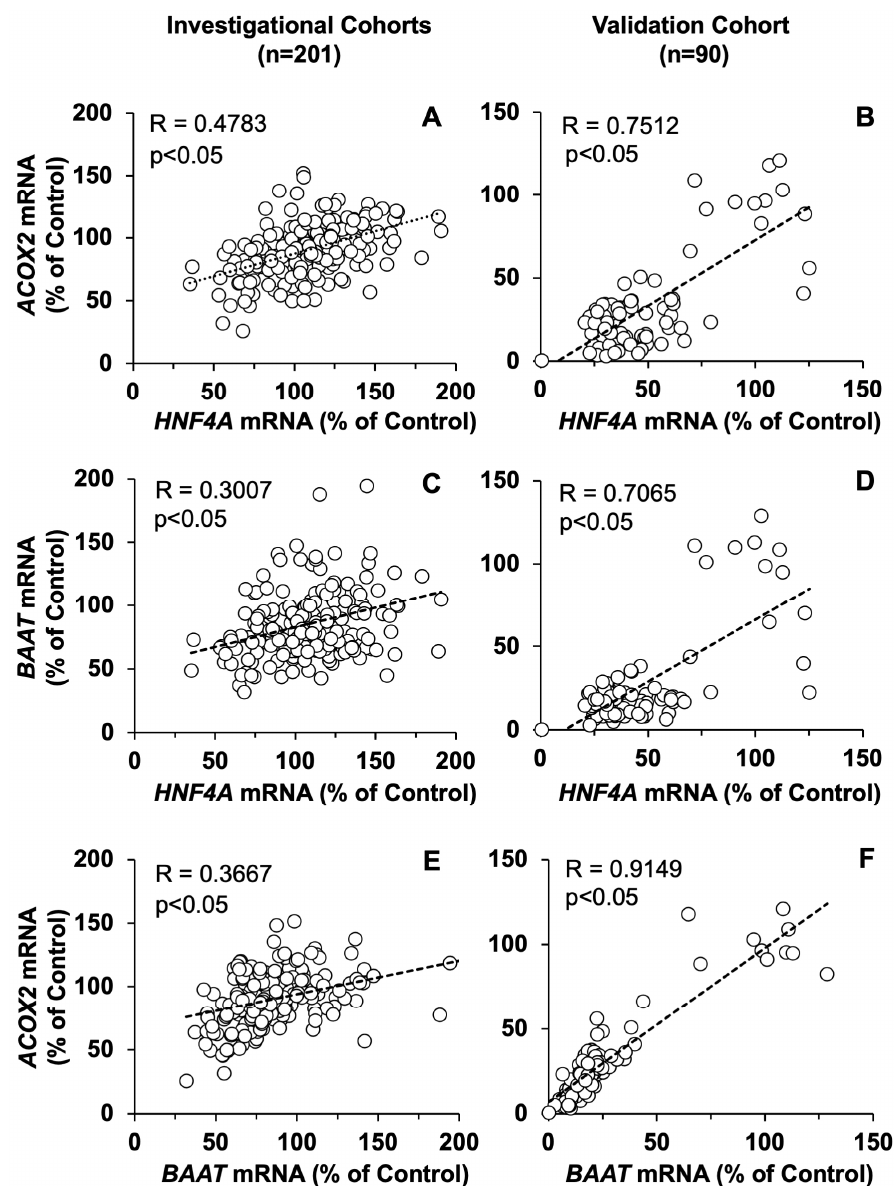
Figure 7. Inter-relationship among the mRNA expression levels of ACOX2, BAAT, and HNF4 α in the liver of patients belonging to the investigational ( A , C , E ) or validation ( B , D , F ) cohorts. To correlate the values obtained from different genes in different cohorts, the percentage changes in the expression of each gene versus the average value of mRNA abundance in the control group of the same dataset were used in the plot. These data were analyzed to calculate the statistical significance of the Spearman’s rank correlation coefficient (Wessa, P. 2022, Free Statistics Software, Office for Research Development and Education, version 1.2.1, URL https://www.wessa.net; accessed on 20 May 2022).